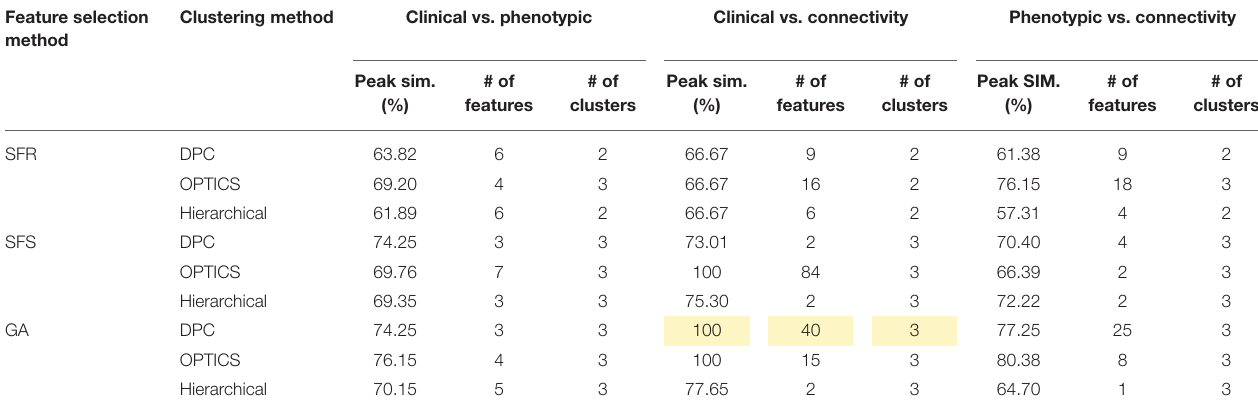
TABLE 10 | Peak similarity (highlighted), corresponding number of features, and number of clusters obtained using SFR, SFS, and GA with different clustering methods for PTSD/PCS dataset. Feature selection Clustering method Clinical vs. method